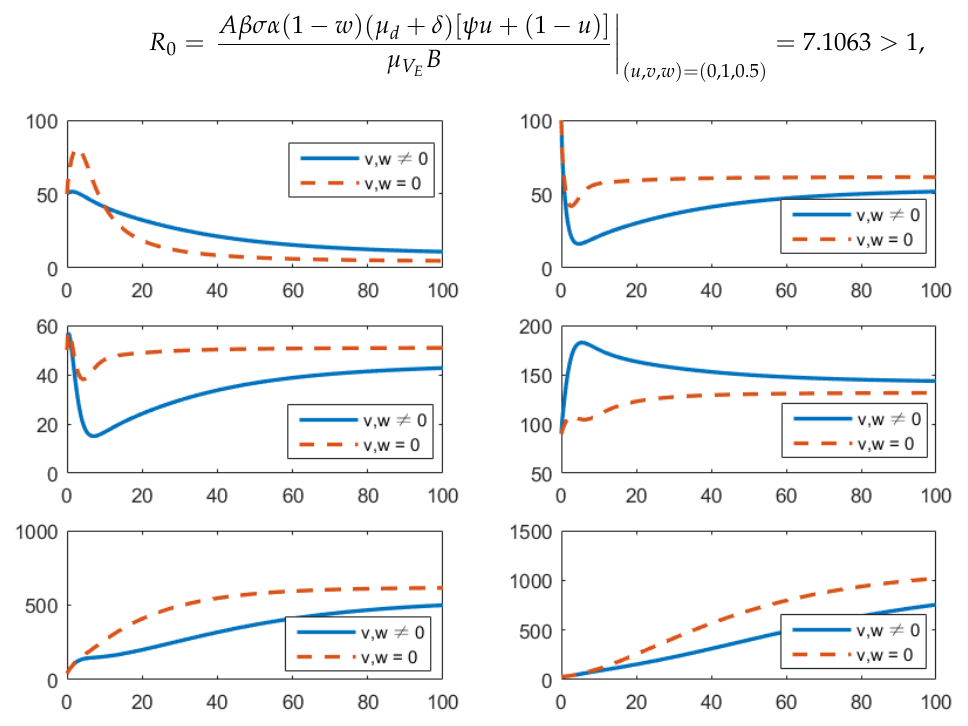
Figure 2. Comparison of adopting strategy A 1 versus not adopting. From left to right is S , E , I , R , V I , V E , respectively. The x -axis and y -axis, respectively, represent the time (days) and the corresponding population